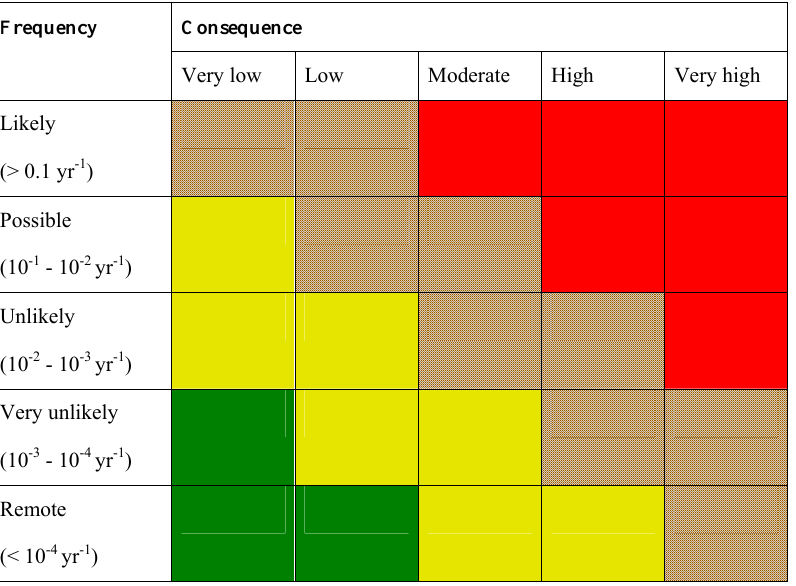
Table 5. An example of a risk matrix (adapted from Cox, 1998). The red colour denotes areas of intolerable risk, the dashed orange and the dotted yellow cells indicate areas where risk reduction measures should be implemented, and the green colour shows areas where risk is broadly acceptable.